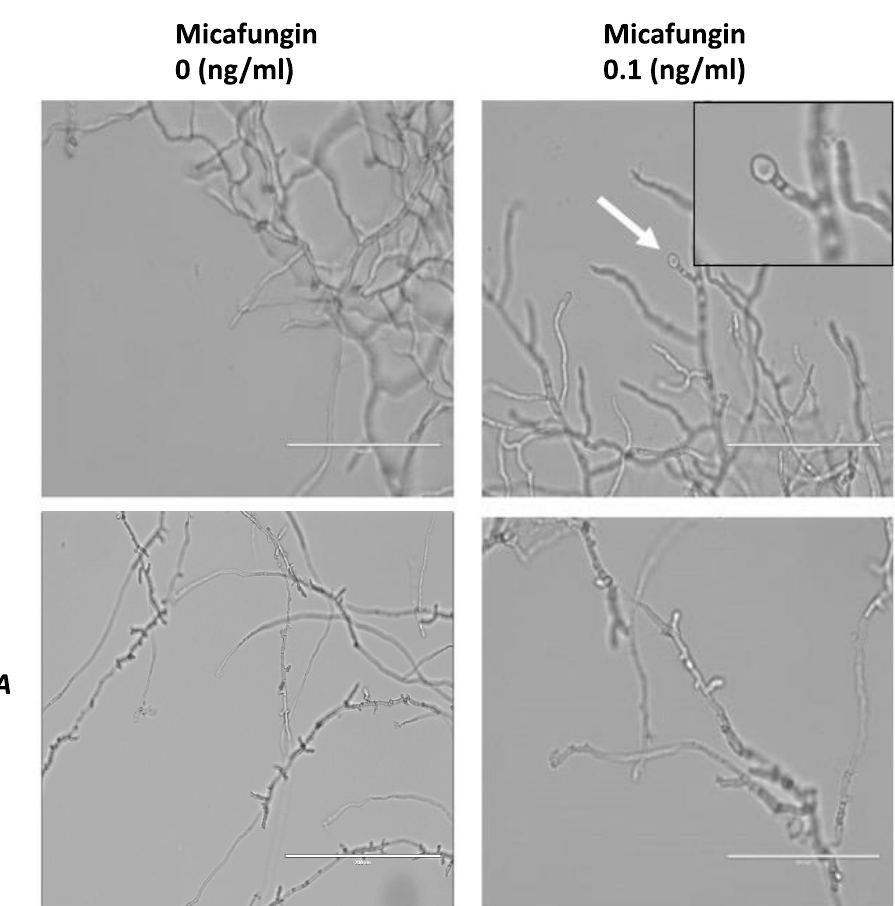
Figure 5. Development of terminal hyphal bulges following exposure to micafungin. Terminal bulges that resemble spores develop at hyphal tips in wildtype 9 h following exposure to micafungin. No bulges were observed in the Δ mpkA strain. Scale bar is 100 µm. Images captured on an EVOS FL microscope.